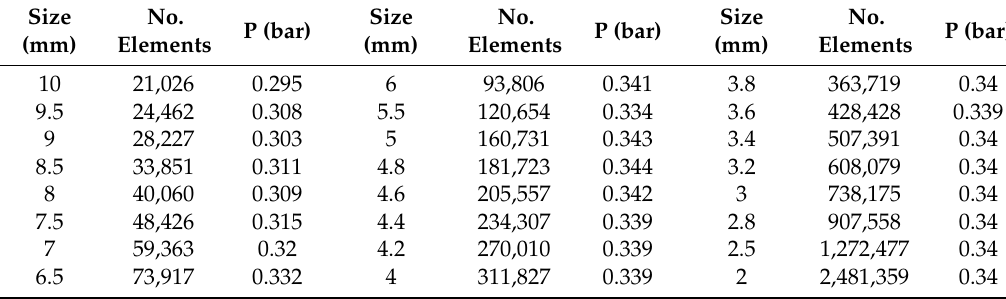
Table 1. Results of the mesh convergence